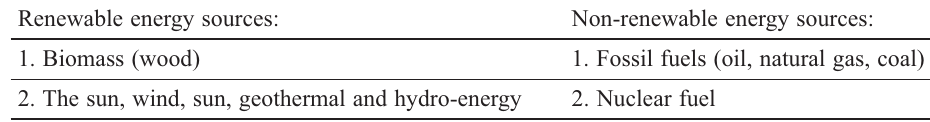
Table 3. Sources of energy